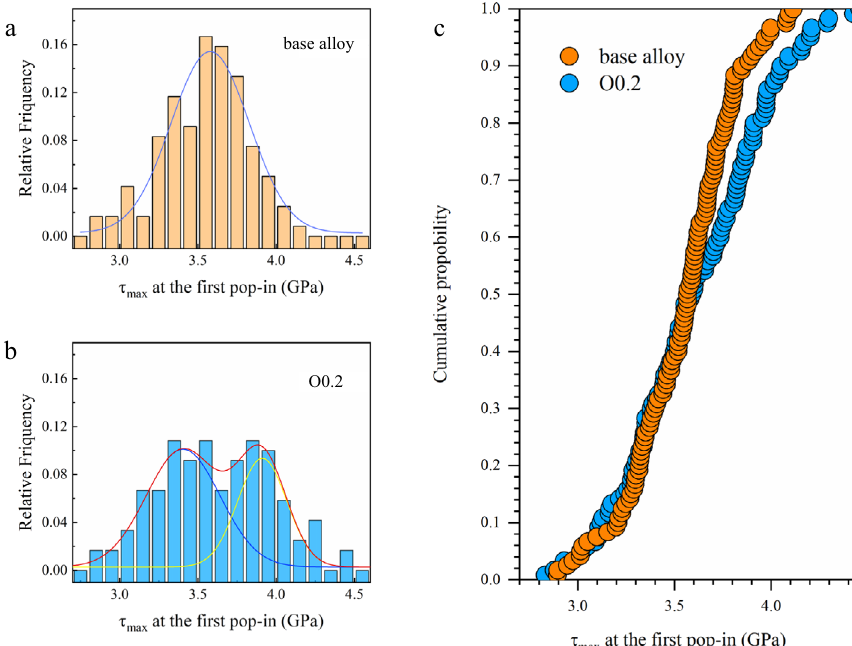
Fig. 2 Relative frequency distributions of τ max probed by nanoindentation of the base alloy. a and alloy O0.2 ( b ), and the corresponding cumulative probability of τ max ( c ). Relative frequency distributions of τ max of O0.2 in b shows a bimodal characteristic and can be fi tted by two Gaussian